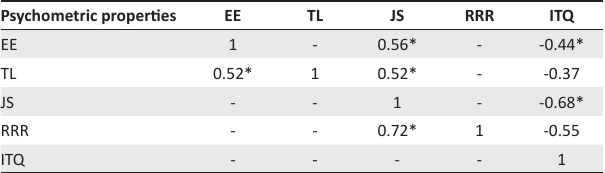
TABLE 5: Summary table of correlations.